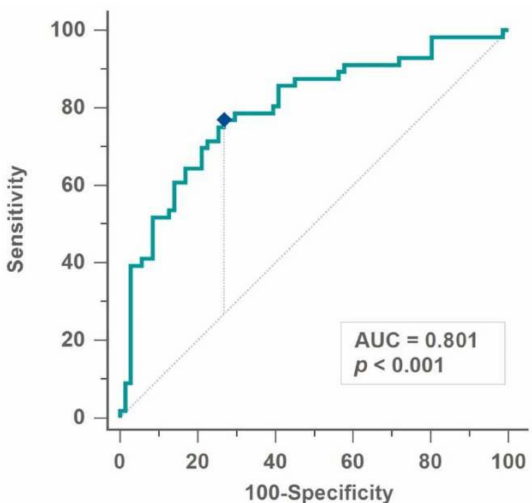
Figure 1. ROC curve of the probability calculated by the prediction formula. The optimal cut-off point (diamond mark) yielded a sensitivity of 76.8% and a specificity of 73.2%. Gout flares occurred within a mean of 3.5 (range, 1–22) days, postoperatively, with the highest number of gout flares recorded on the second postoperative day (Figure 2). The mean uric acid level upon the onset of gout flare was 6.2 ± 2.0 mg/dL. More cases with monoarticular involvement (26/47, 55.3%) than cases with involvement of two or more joints were recorded. Most flare patterns involved only the joints in the lower extremities (40/47, 85.1%). Only three patients presented with flare-ups limited to the upper extremities (6.4%), while four patients had flare-ups in both the upper and lower extremities (8.5%). The most frequently involved joints were the knee joints (31/47, 65.9%), ankle joints (24/47, 51.1%), and first metatarsophalangeal joints (7/47, 14.9%) (Table 4).